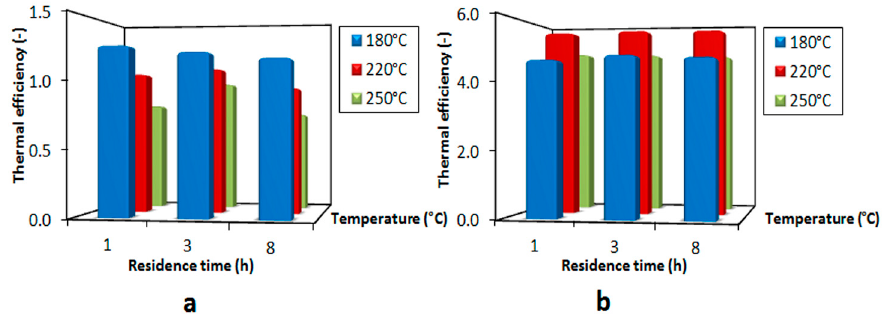
Figure 4. Thermal efficiency at different HTC temperatures (180, 220, 250 °C) and residence times (1, 3, 8 h): ( a ) OSC; ( b ) GM.